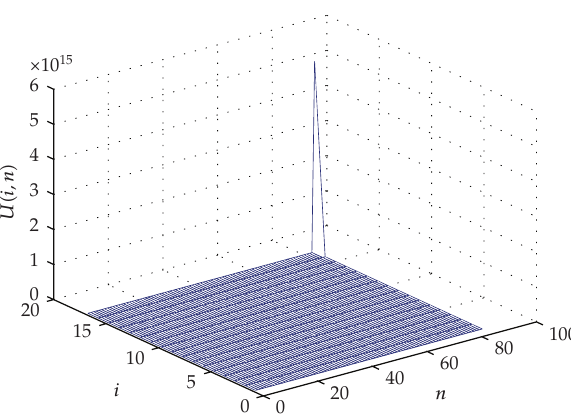
Figure 5: Evolution of the discrete solution, q (cid:2) 4, p (cid:2) 2 (cid:3) explicit scheme (cid:4) .